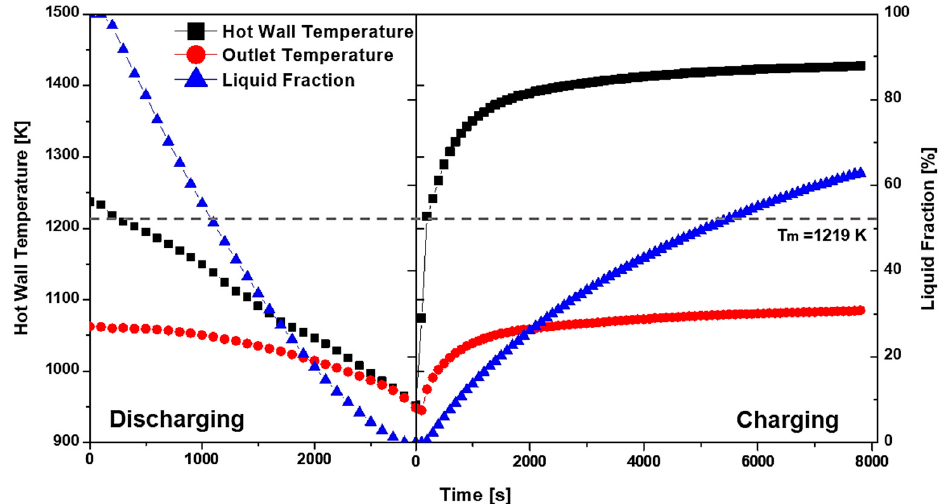
Figure 6. Average receiver hot wall temperature, working fluidoutlet temperature, and PCM liquid fraction during charging and discharging processes.